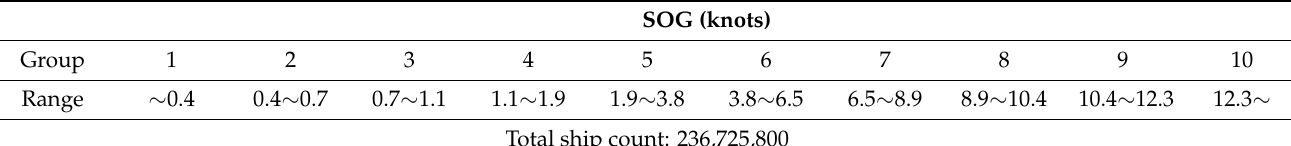
Table 6. SOG classification among the the 10 groups. SOG